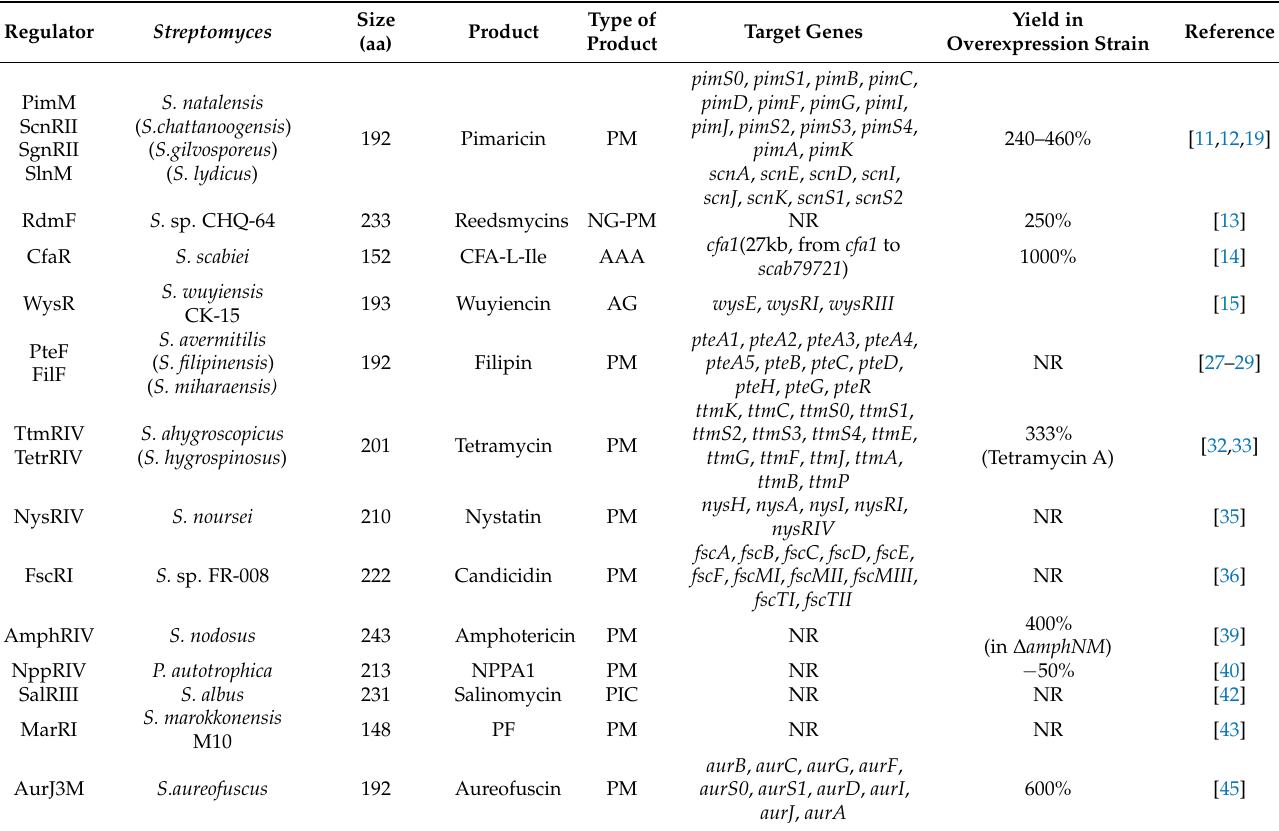
Table 1. Information regarding the reported PAS-LuxR family